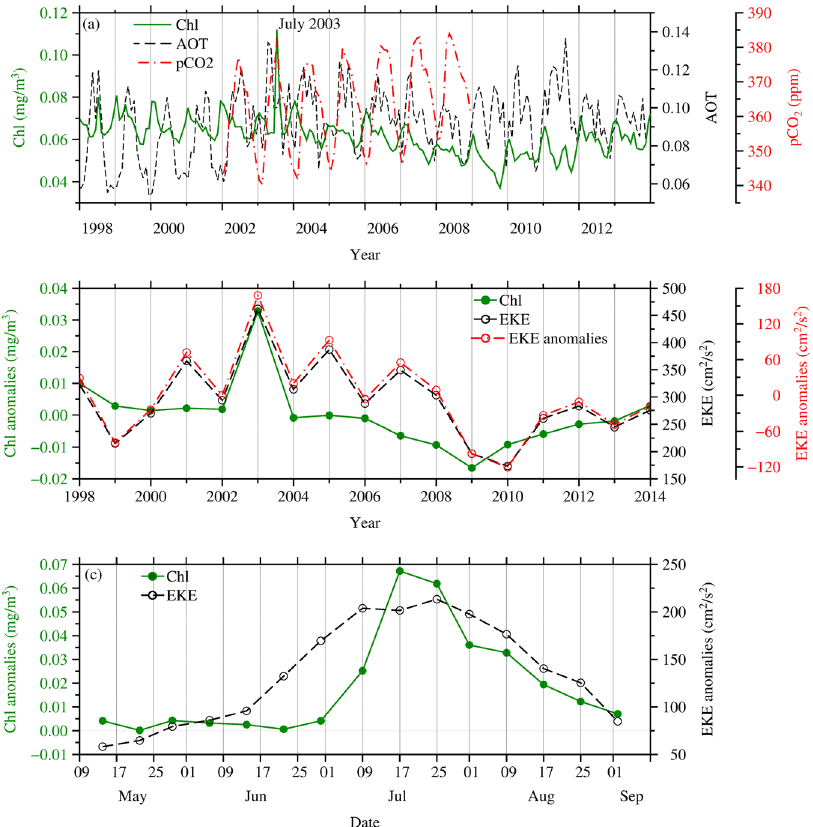
Figure 2. Time series of ( a ) monthly mean Chl, AOT and p CO 2 , ( b ) Chl concentration anomalies, EKE means and EKE anomalies in July and August from 1998 to 2014 and ( c ) anomalies of EKE and Chl concentration from May 10 to Sep. 13, 2003, within 145–155°E and 17–25°N.